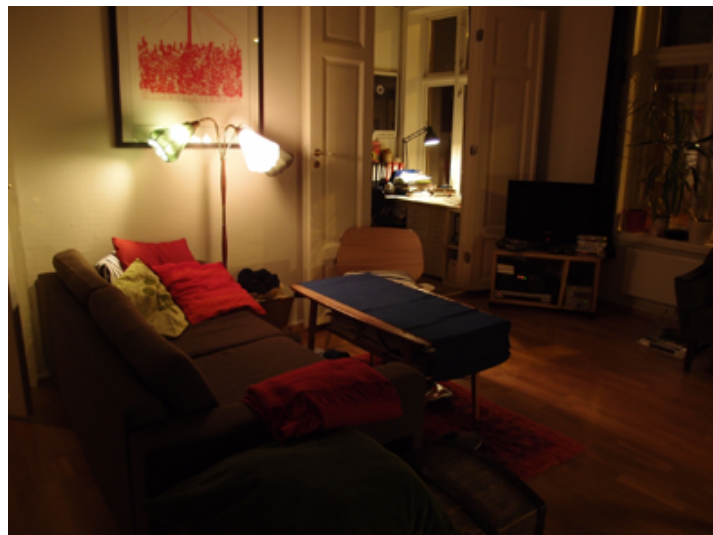
Figure 8. Living room (Study 2).